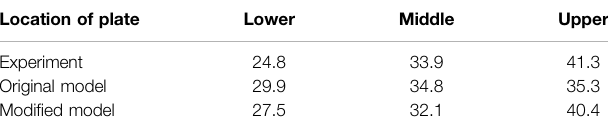
TABLE 5 | Condensation rate fraction on the three condensers in Phase A of MISTRA ISP47 experiment ( t (cid:1) 4000 s). Location of